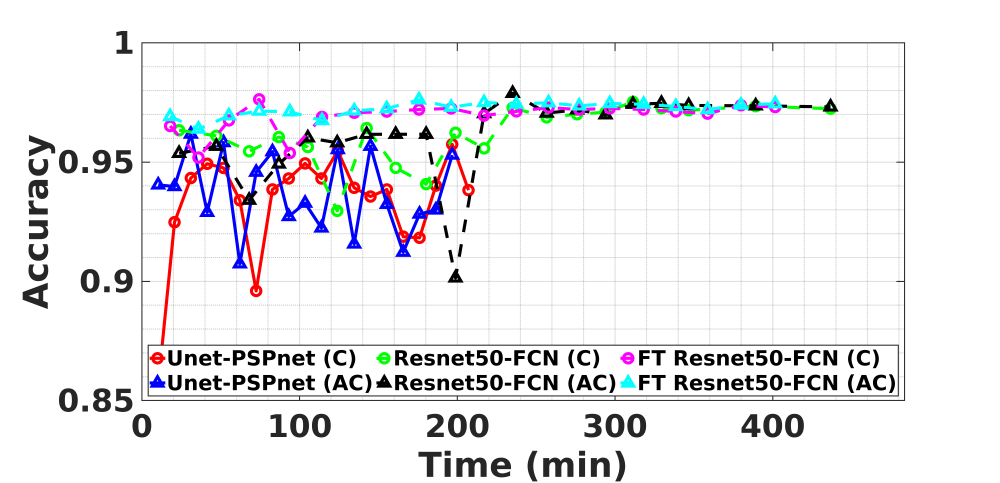
Figure 7. Comparison Learning Curves: Evolution of the pixel accuracy of the U − Net–PSPnet model trained from a random initialization and of a pre − trained ResNet50–FCN model that has been fine-tuned. The curves show that the pre − trained Resnet50-FCN models achieve an accuracy above 95% much faster than the U − Net–PSPnet model. Note: FT refers to